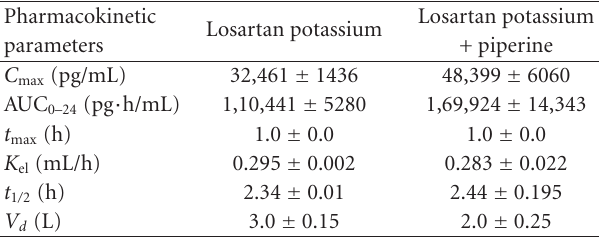
Table 19: Comparison of pharmacokinetic parameters of losartan potassium- and losartan potassium + piperine-treated male New Zealand white rats after single oral administration (100mg/kg)